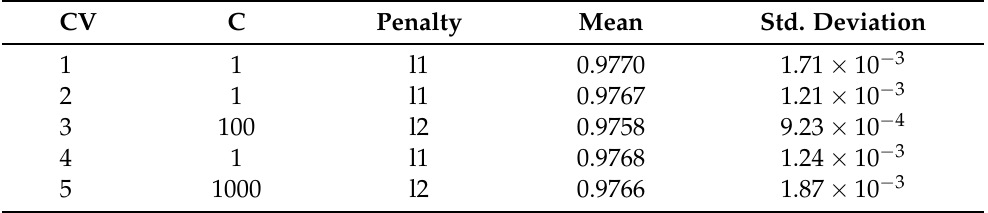
Table 1. Best Logistic Regression model by iteration.